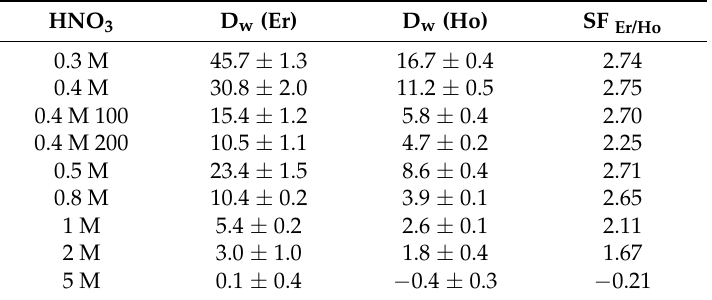
Table 1. D w and SF of Er and Ho in HNO 3 .